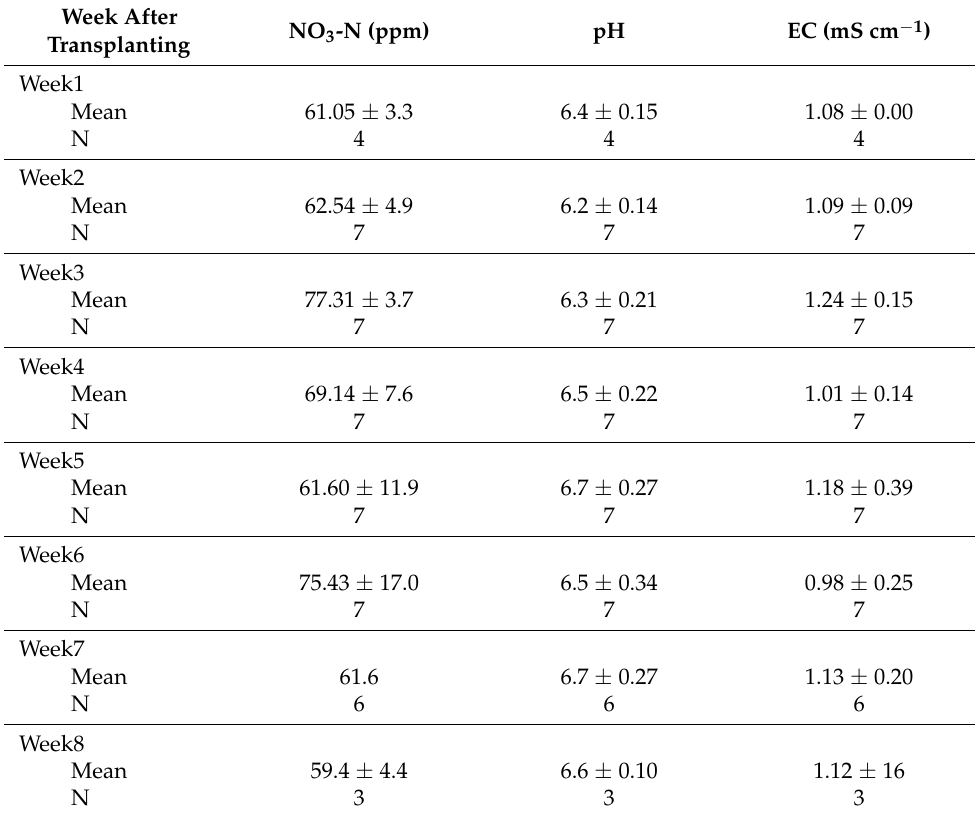
Table 1. Weekly AE NO 3 -N, pH, and EC supplied from the aquaculture unit. Daily measurement for 2019 trial from the emitter and averaged over a 7-day period.